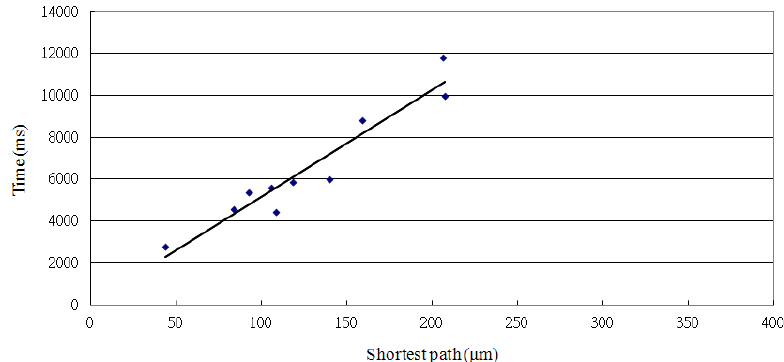
Figure 15. Relationship between the positioning time and the shortest path with a combination of voltage and time as the control factor.